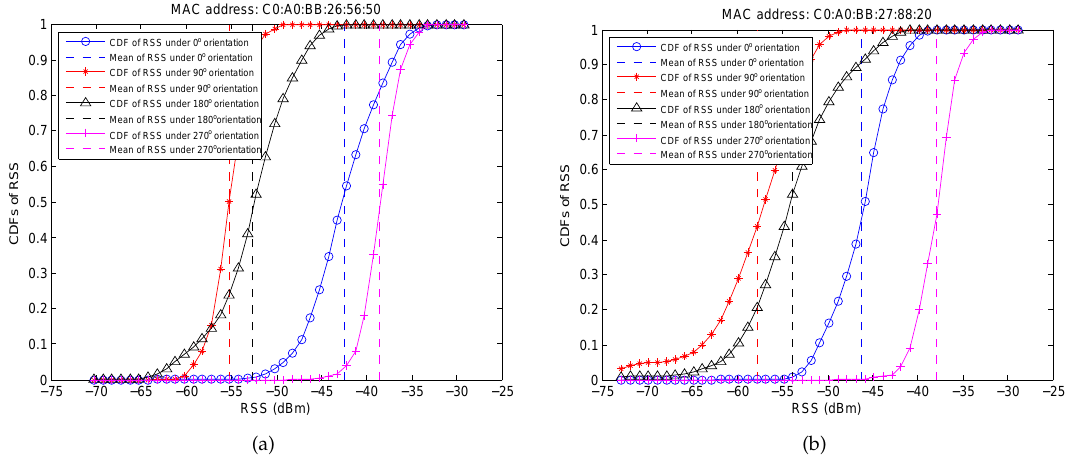
Figure 7. CDFs of RSS under four different orientations for 3 min. ( a ) RSS from AP with the